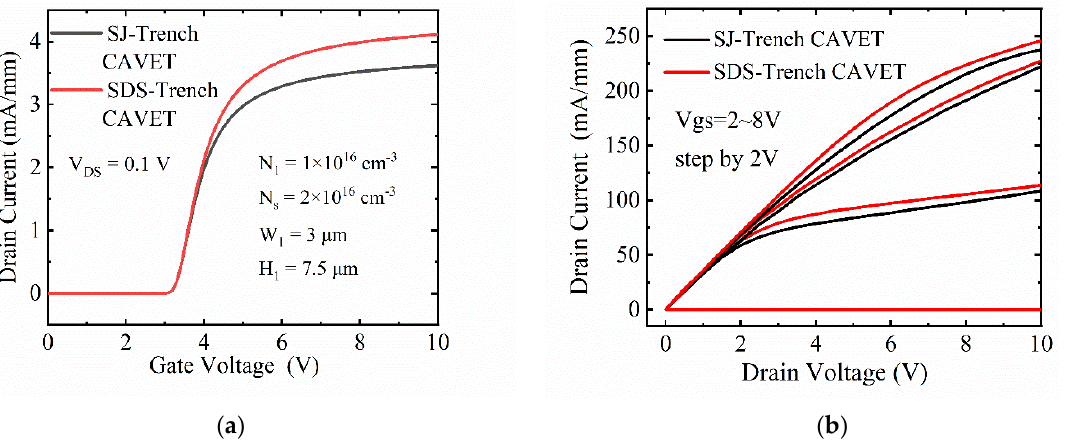
Figure 3. Comparison of on-state I–V characteristics for two structures, including ( a ) transfer curves and ( b ) output curves.